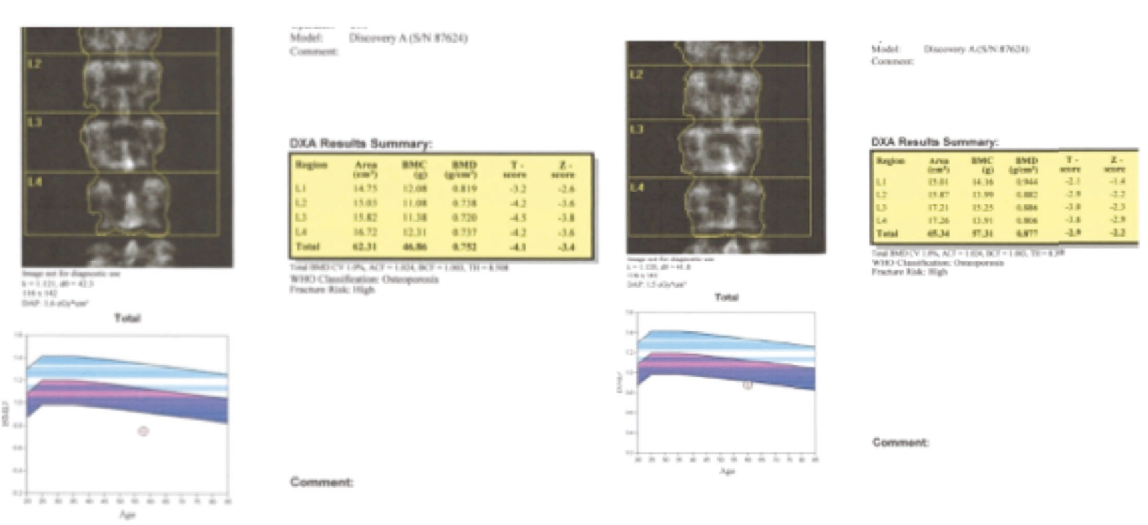
Figure 4: Pretreatment and post-treatment DXA scans of the lumbar